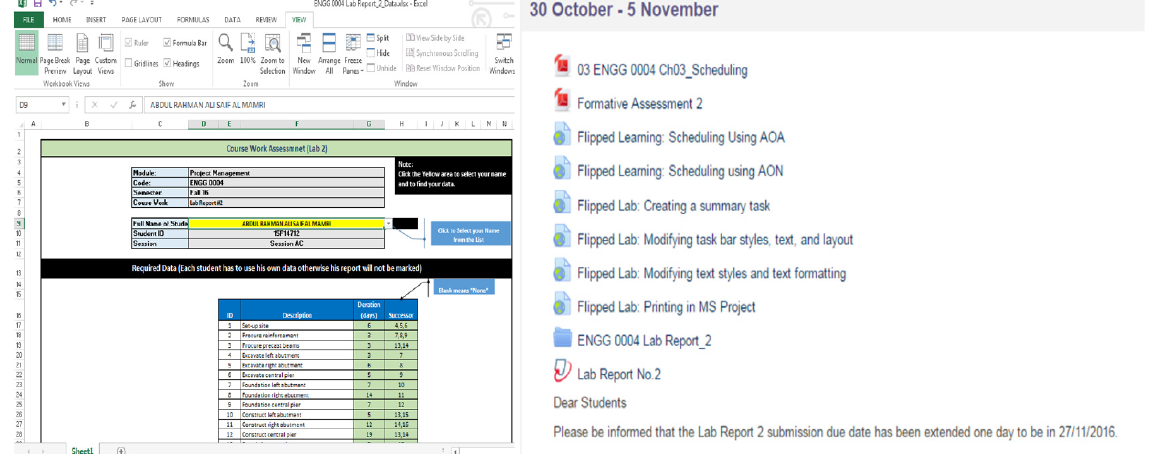
Figure 3. The use of individual data and turn-it-in software to check plagiarism percentage